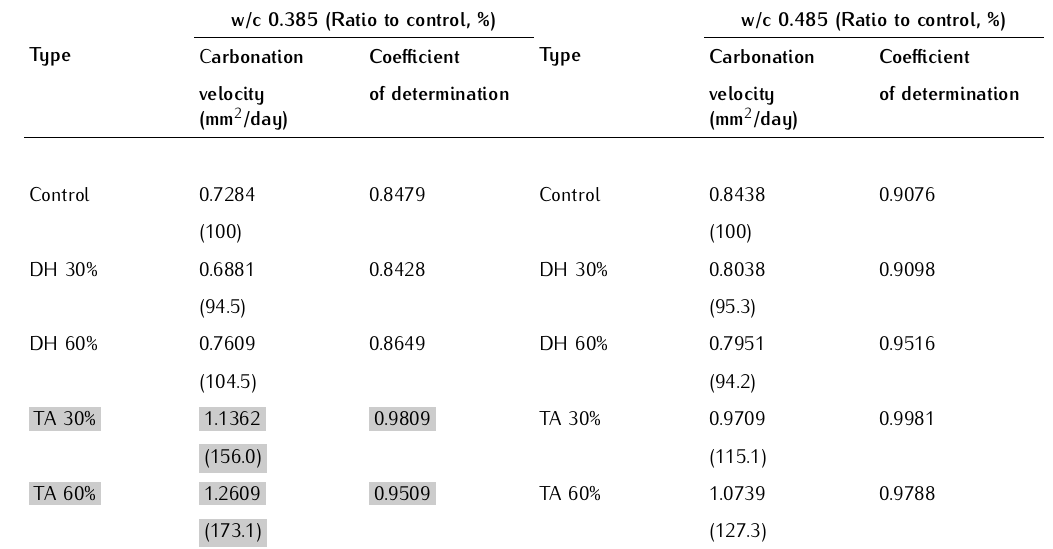
Table 7. Regression analysis for carbonation depth.